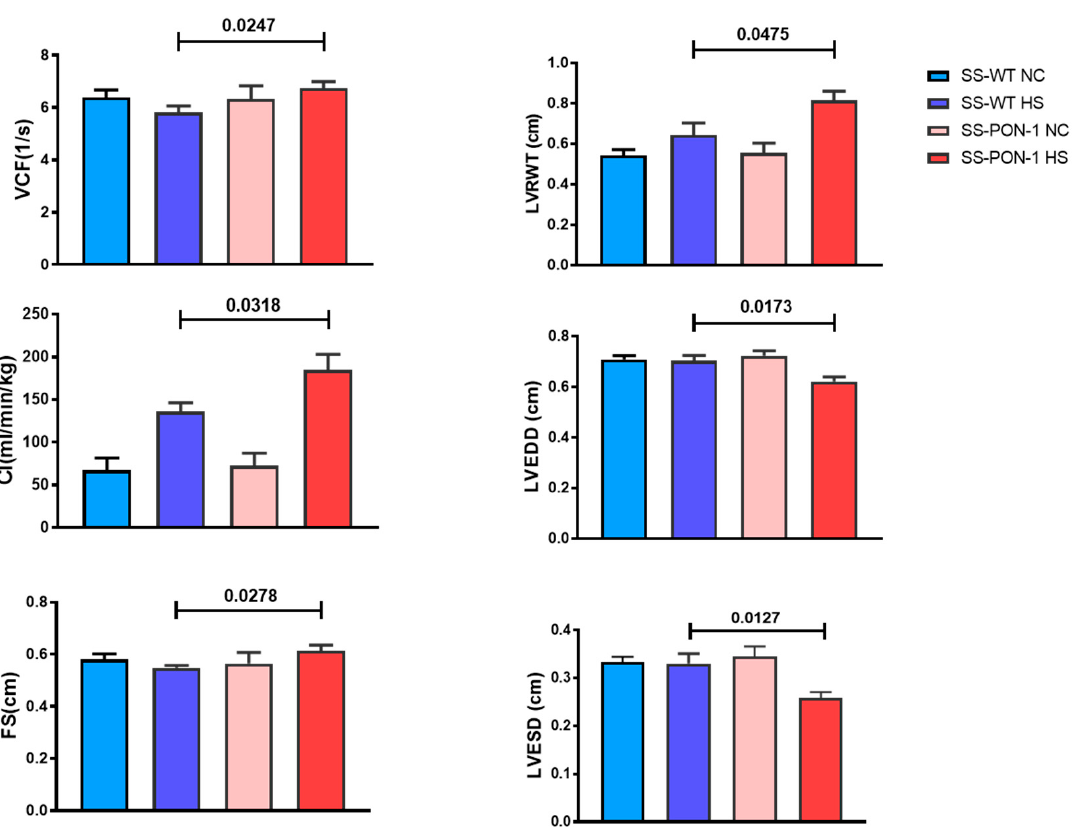
Figure 2. Echocardiographic evaluation after 4 weeks on 8% high-salt diet. SS-PON-KO HS rats demonstrated significantly decreased end-diastolic and -systolic dimensions, and a significantly increased relative wall thickness as well as increase in global systolic function as shown by increases in fractional shortening, velocity of fractional shortening, and cardiac index ( N = 8). Data are presented as the mean ± standard error of the mean. One-way ANOVA and post hoc multiple comparison tests were used to assess statistically significant differences between the groups. VCF: velocity of circumferential fiber shortening, CI: cardiac index, FS: fractional shortening, LVRWT: left ventricular relative wall thickness, LVEDD: left ventricular end-diastolic dimension, LVESD: left ventricular end-systolic dimension.